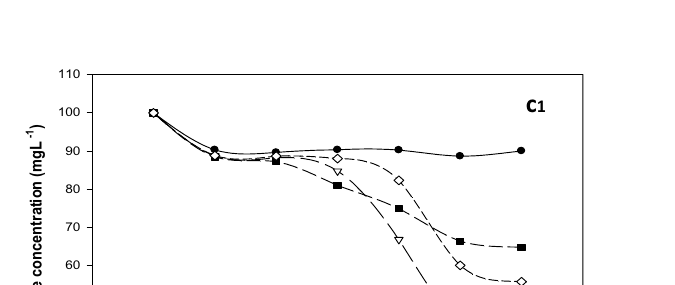
Table 1. Levels of unmetabolized naphthalene (ppm) in bacterial cultures at day 18 with varying temperatures. ND not detected, SD standard deviation.